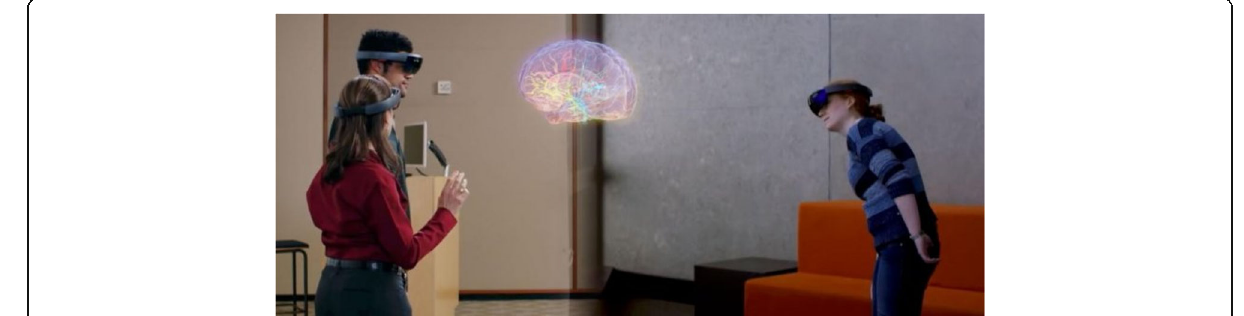
Fig. 14 HoloAnatomy AR system (source: CWRU